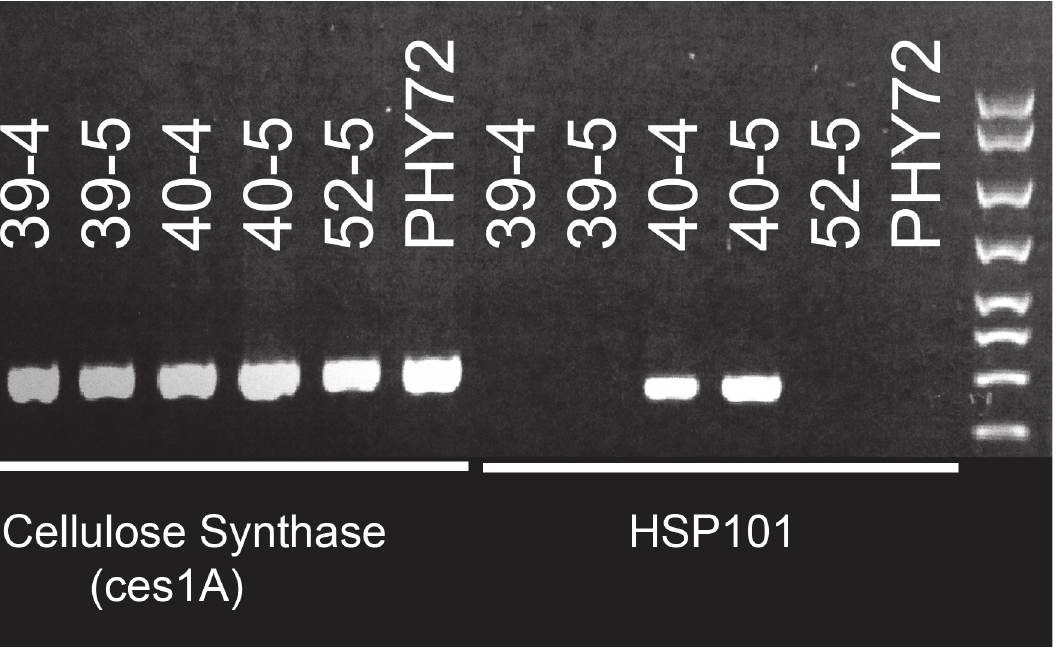
Fig 3. Genomic PCR analysis of cellulose synthase and AtHSP101 in segregating transgenic cotton lines and a commercial check (Phytogen 72).